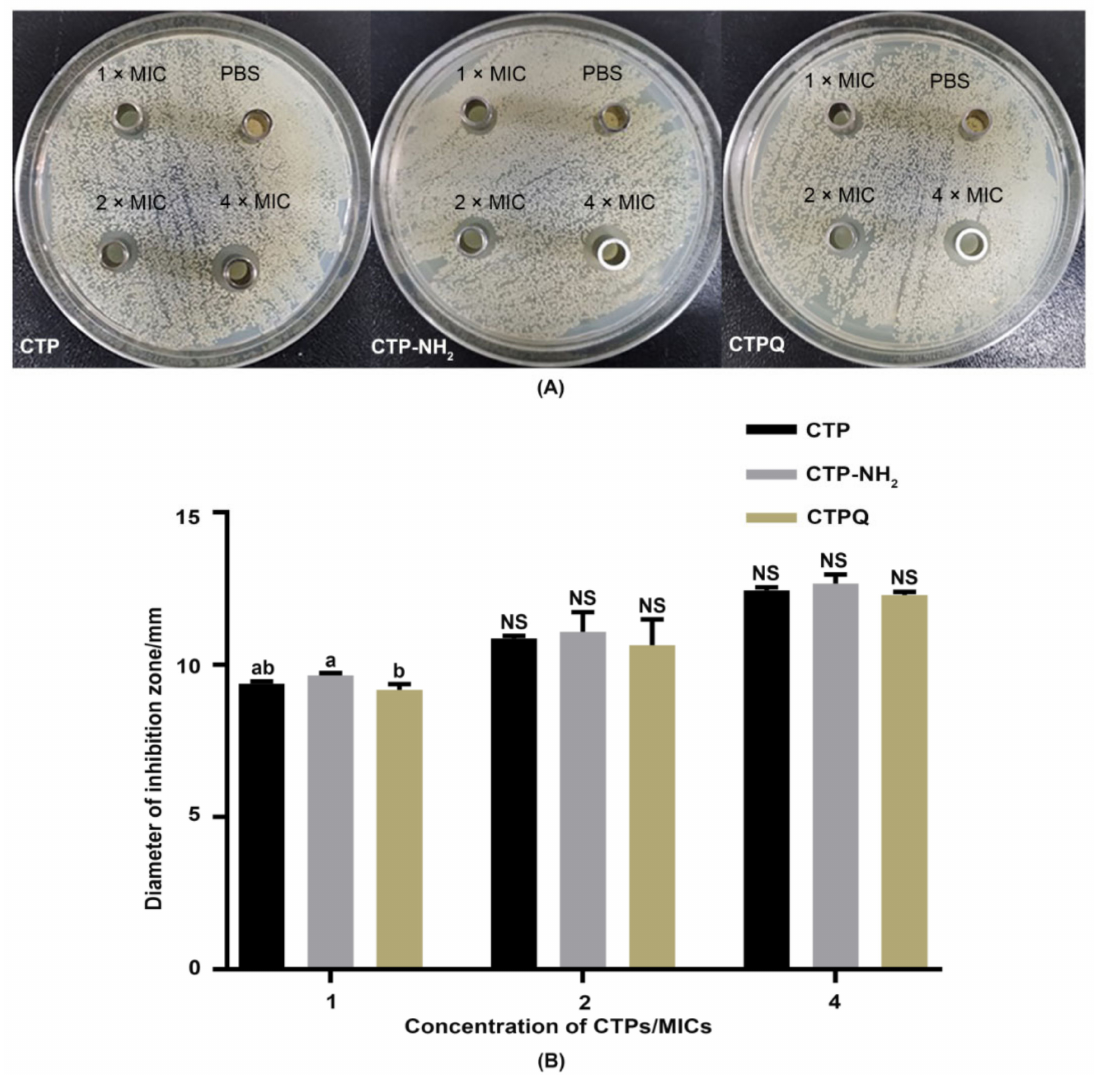
Figure 2. ( A ) The inhibition zone of S. aureus ATCC 43300 treated with CTPs at 1, 2, and 4 × MIC (32, 64 and 128 µ g/mL) and ( B ) their diameters. Data were given as the mean value ± SD from three biological replicates. a,b : Different lowercase letters mean significantly different ( p < 0.05) values were expressed as mean ± SEM; NS: not significant ( p > 0.05) ( n =